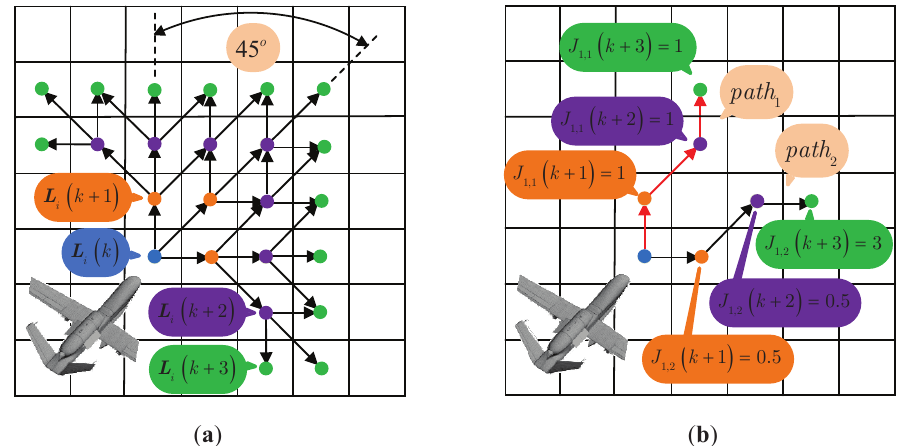
Figure 2. Schematic diagram of N p SAP: ( a ) N p = 3; ( b ) N p SAP to avoid greedy